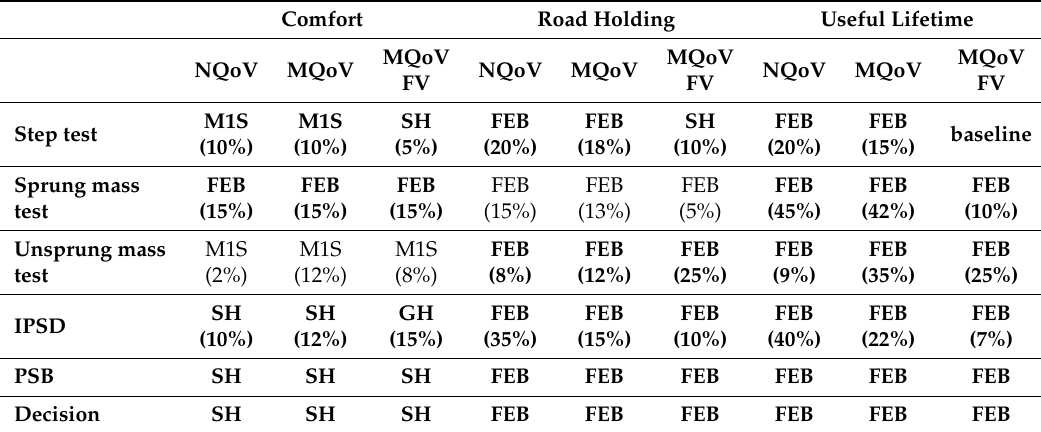
Table 13. QoV results in closed